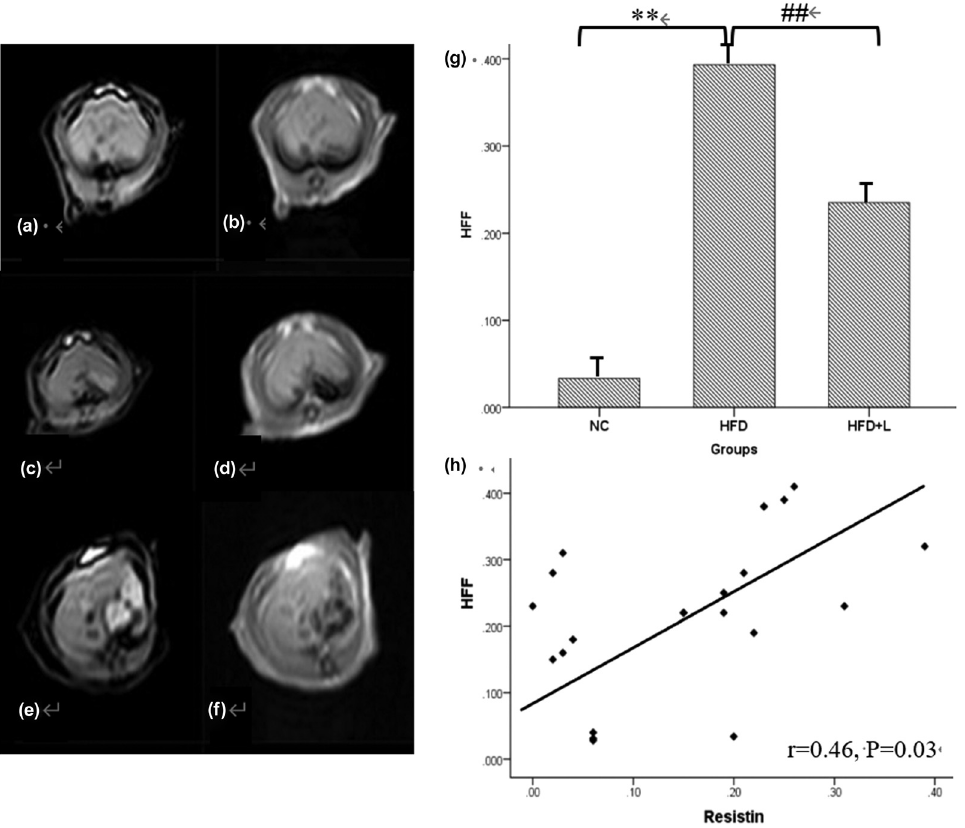
Figure 3: In - phase and out - of - phase magnetic resonance ( MR ) images and correlation of serum resistin levels with the HFF value in di ff erent groups of rats. ( a and b ) Representative liver in - phase and out - of - phase MR images of rats in the normal control group. The signal of the out - of - phase image was nearly the same as that of the in - phase image. ( c and d ) Representative liver in - phase and out - of - phase MR images of rats fed an HFD. The out - of - phase image had signi fi cantly lower signal than the in - phase image, and the HFF value was 32.23%. ( e and f ) Representative liver in - phase and out - of - phase MR images of rats fed HFD and treated with 100 mg/kg liraglutide. The out - of - phase image had slightly lower signal than the in - phase image, and the HFF value was 18.67%. ( g ) HFF value for rat livers of each group. The HFD group have higher HFF value than NC group, and HFD + L group showed considerable lower HFF value than HFD group. Data are shown as mean ± standard deviation for 15 rats per group. ** p < 0.01 compared with the normal control group; ## p < 0.01 compared with the HFD group. Abbreviations: NC, normal control; HFD, high - fat diet; HFD + L, high - fat diet and treatment with 100 mg/kg liraglutide. ( h ) Serum resistin level showed a signi fi cant positive correlation with the HFF value. However, there was no signi fi cant correlation between serum visfatin level and HFF value.